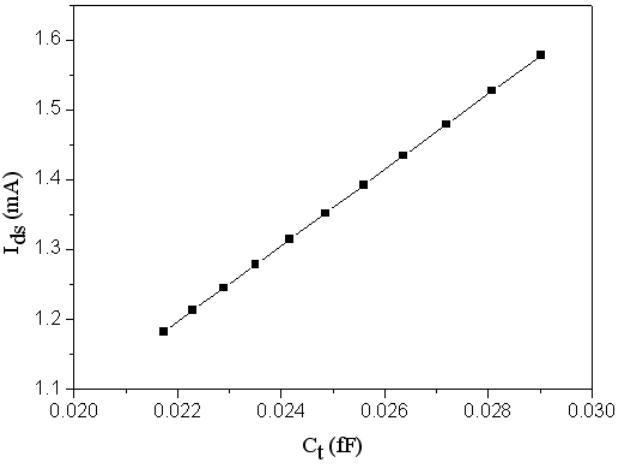
Figure 6. Relation of drain current and capacitance in the pressure